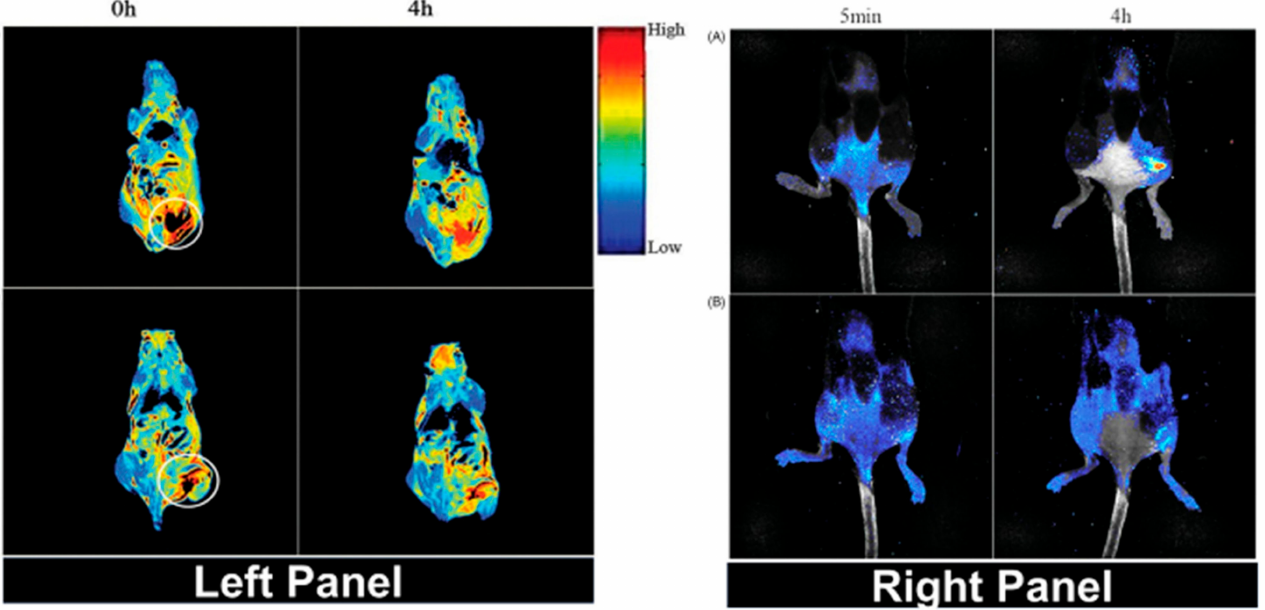
Figure 4. Whole-body T 2 images in pseudo-color mode (Left Panel) and fluorescent images (Right Panel) in a bone metastasis model at different time intervals of injection of ( A ) cyclic arginine-glycine-aspartate (cRGD)-conjugated magnetic-fluorescent (MF) liposomes and ( B ) unconjugated MF-liposomes. White circles in the left panel represent tumor sites. Reprinted with permission from ref. [44]. Copyright 2015 Taylor &